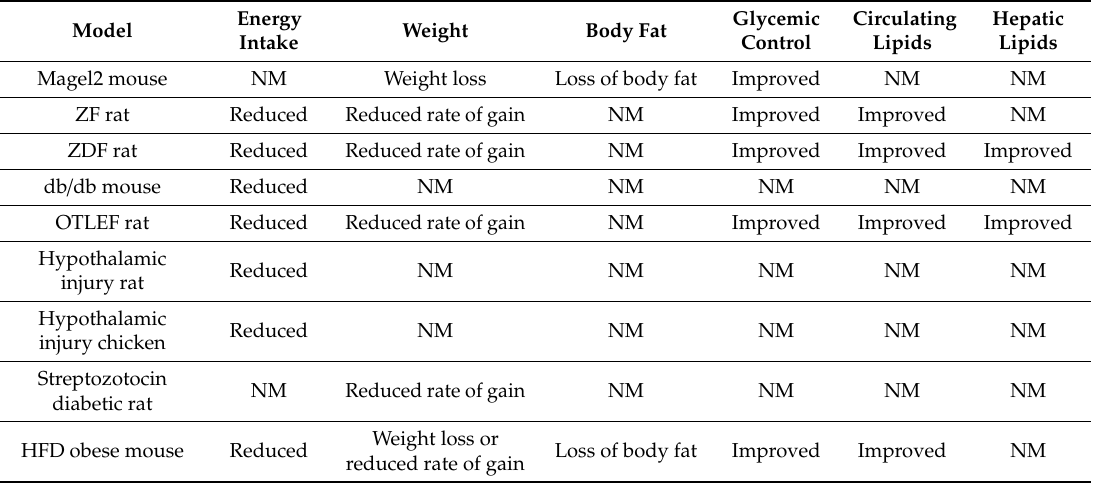
Table 1. Tabular summary of responses to K ATP channel activator treatment in nine animal models of hyperphagic